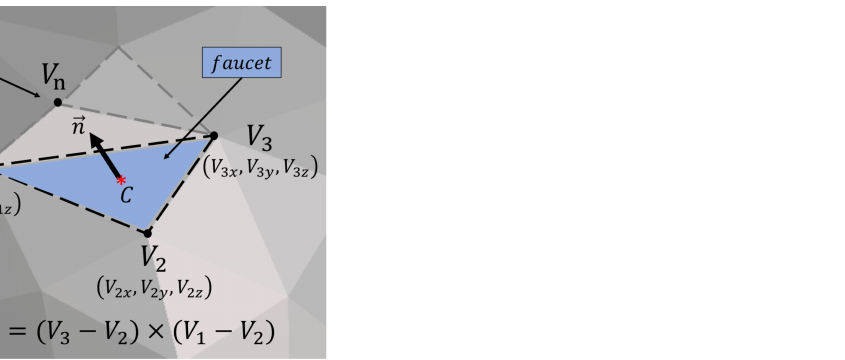
Figure A1. Faucets of the STL file are defined by three vertices and a normal vector, which is defined as the cross product of two vectors.